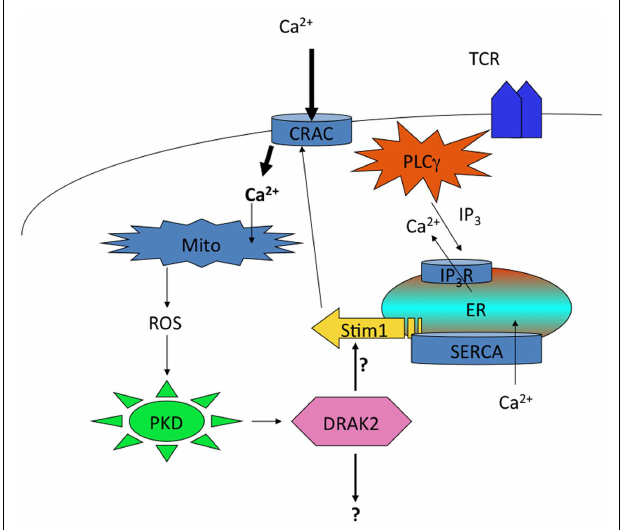
FIGURE 3 | Regulation of DRAK2 activity inT cells via Ca 2 + -induced respiratory burst .TCR induced Ca 2 + depletion from ER stores results in opening of CRAC channels.This high cytosolic [Ca 2 + ] promotes the induction ofTCA cycle and OXPHOS in mitochondria, the latter of which release ROS as an OXPHOS byproduct. In addition to inhibiting phosphatases, ROS activate PKD, which itself binds to and activates DRAK2 (likely through transphosphorylation on DRAK2). DRAK2 then impacts Ca 2 + signaling by altering SERCA activity (hypothetical), or other unknown